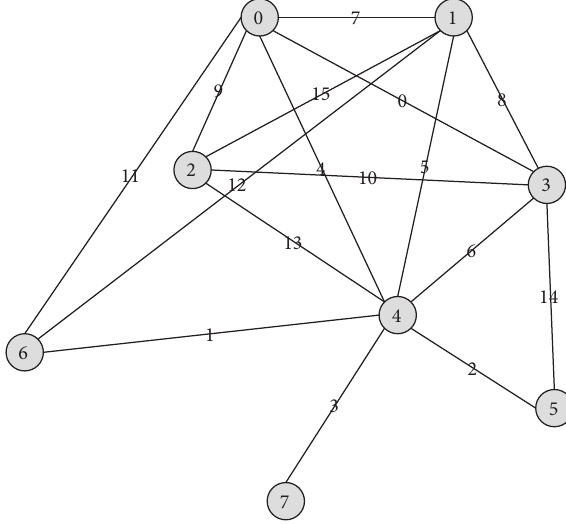
Figure 3: The original network. Table 1: Number of triangle-subgraph sets in the original network.